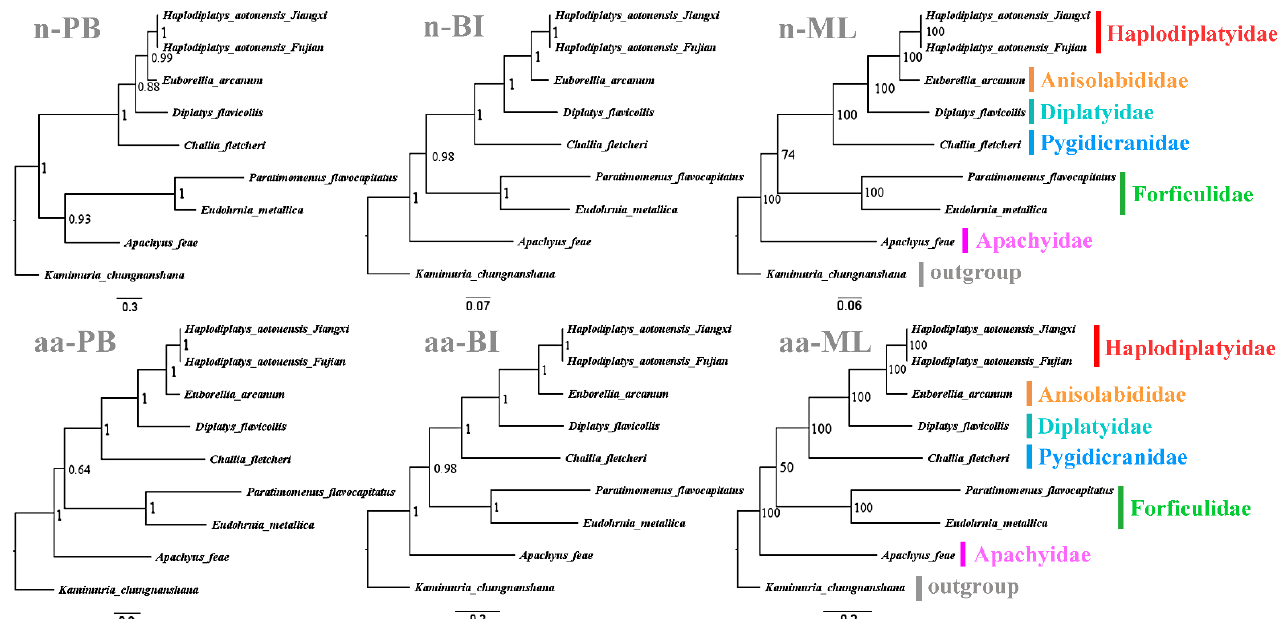
Figure 6. Phylogenetic relationships within Dermaptera inferred from mitogenomic data. Numbers at the nodes are posterior probabilities or bootstrap values. The family names are listed after the species. Abbreviations: n-PB, Phylo–Bayesian tree based on nucleotide dataset; n-BI, Bayesian tree based on nucleotide dataset; n-ML, maximum likelihood tree based on nucleotide dataset; aa-PB, Phylo–Bayesian tree based on amino acid dataset; aa-BI, Bayesian tree based on amino acid dataset; aa-ML, maximum likelihood tree based on amino acid dataset.